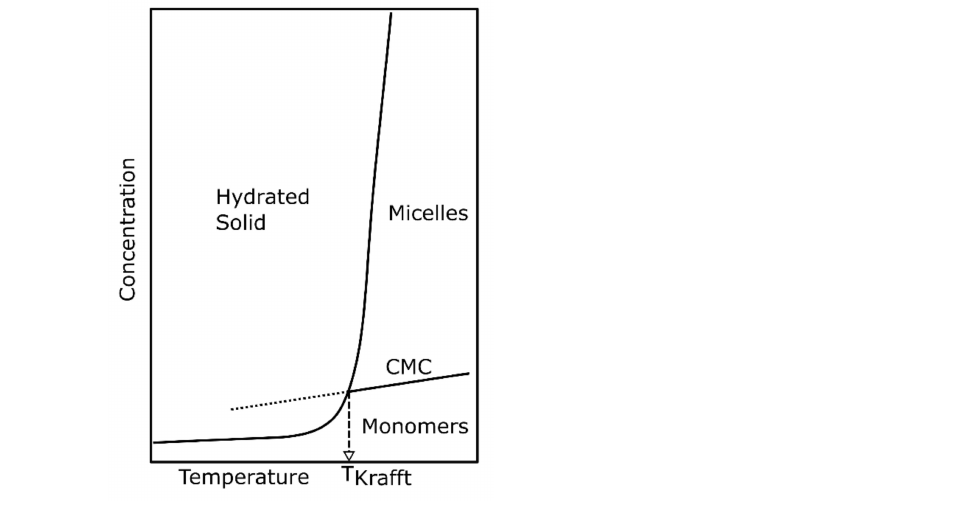
Figure 2. Generalized phase diagram of alkali soaps, own depiction inspired by Ogino et al.